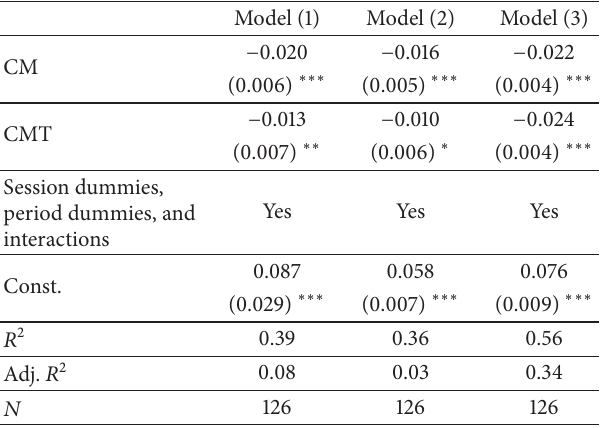
Table 2: Regression analysis market